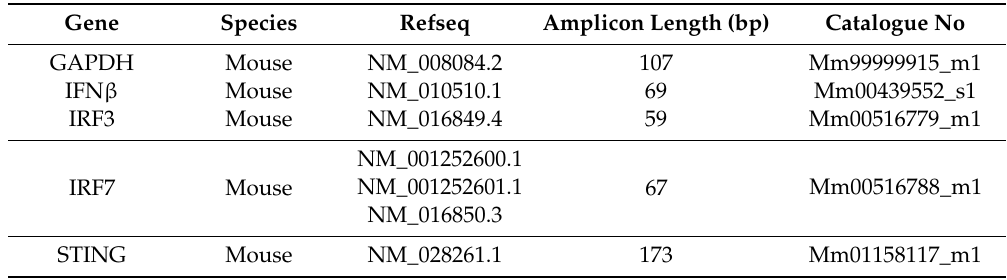
Table 1. Taqman primers used for qPCR analysis.